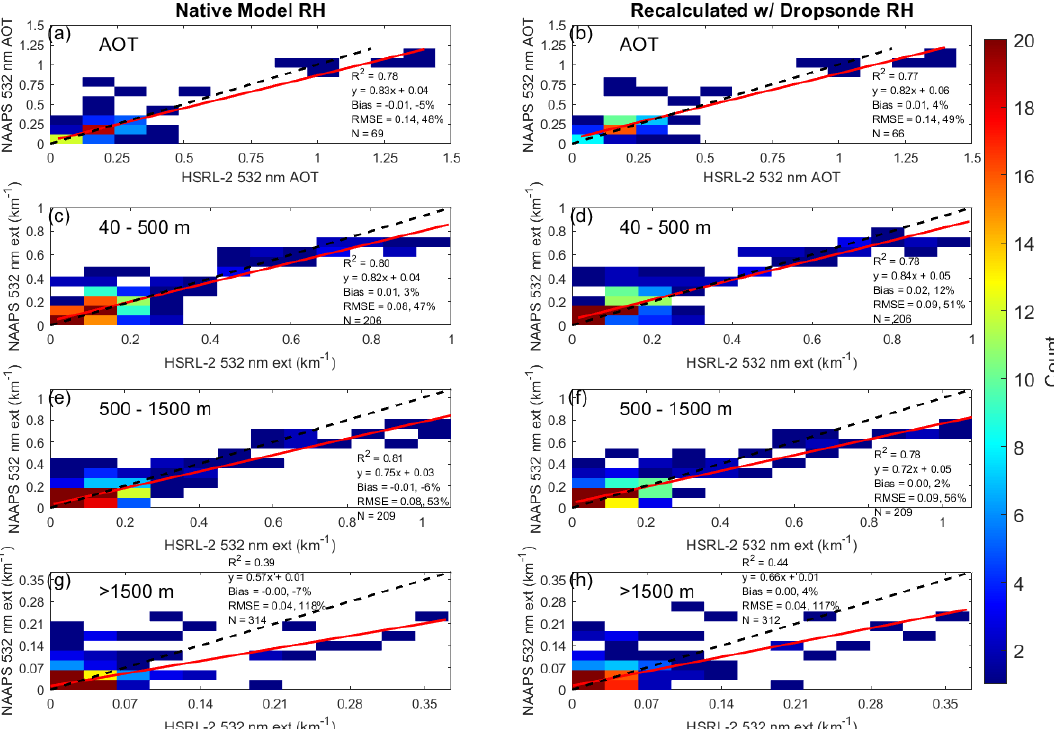
Figure 2. Comparison between simulated (NAAPS-RA) and retrieved (HSRL-2) ( a and b ) 532nm aerosol optical thickness (AOT) as well as 532nm extinction coefficients ( c and d ) between 40–500m, ( e and f ) between 500–1500m, and ( g and h ) above 1500m. Left-hand panels are for NAAPS-RA simulations using modeled relative humidities (RHs), and right-hand panels are for simulations using dropsonde RHs. Linear fits are indicated with red lines, 1 : 1 lines are shown as dotted lines, and the color bar indicates the number of points falling in each bin. Where bias and RMSE are reported, the first and second numbers are the absolute and relative values,